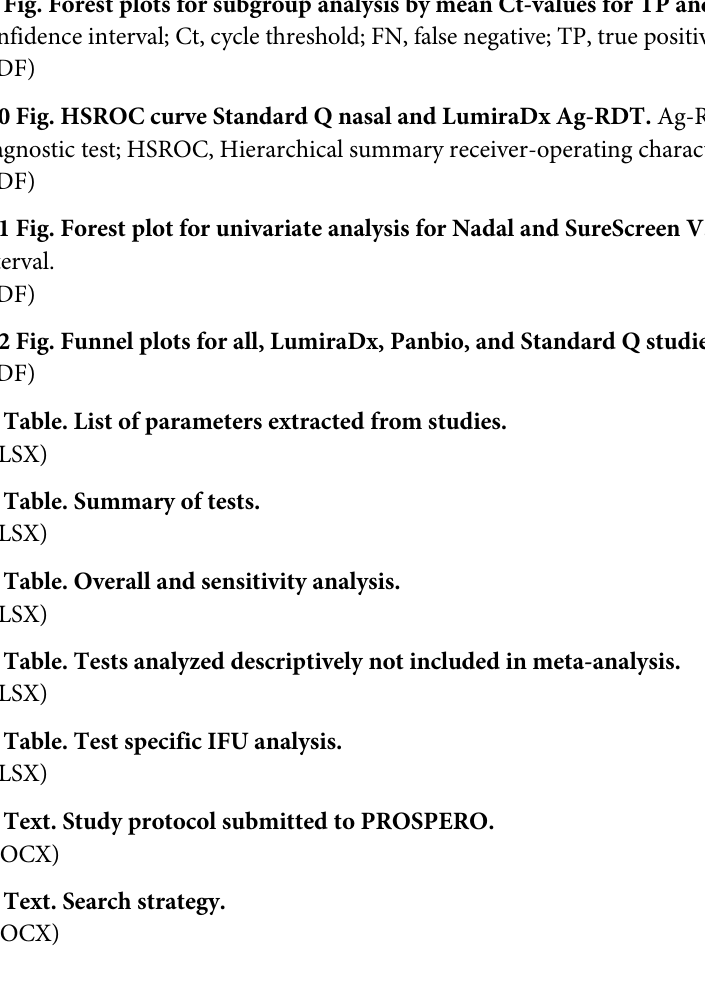
S7 Fig. Forest plots for subgroup analysis by symptomatic versus asymptomatic. CI, confi-